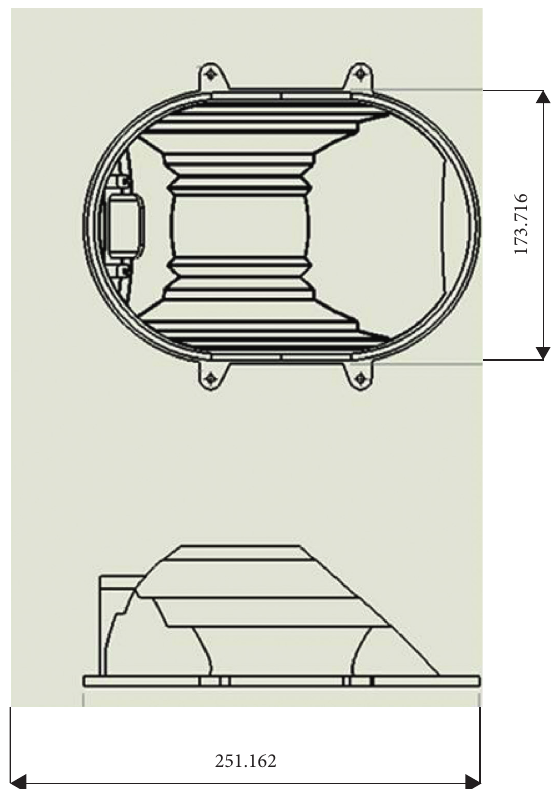
Figure 5: Geometry of proposed freeform-surface street light luminaire.